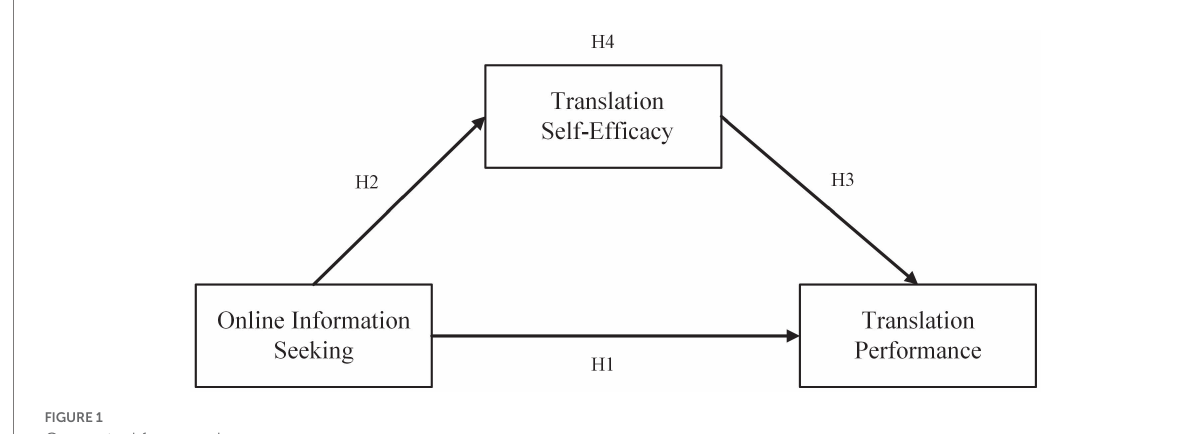
FIGURE 1 Conceptual